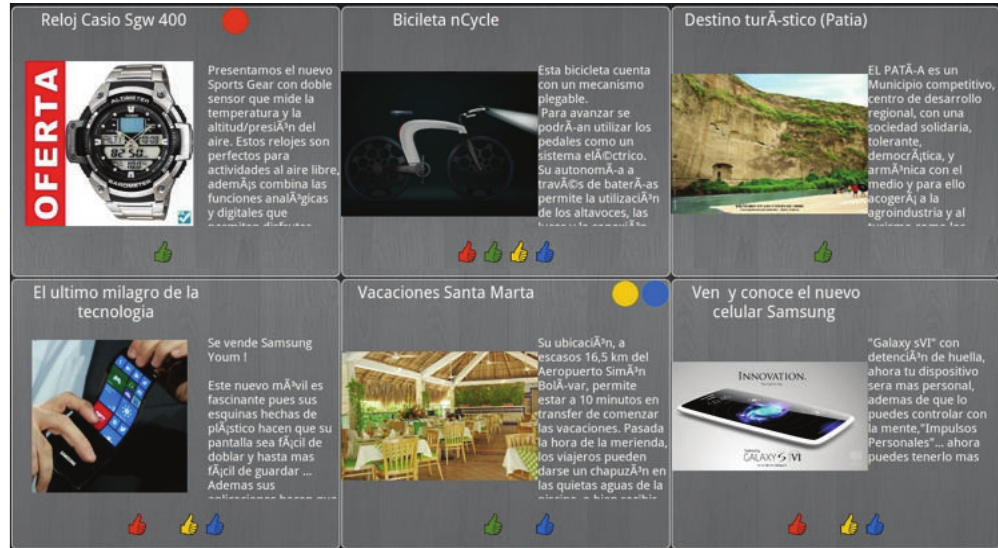
Figure 7: Public display ads screen.